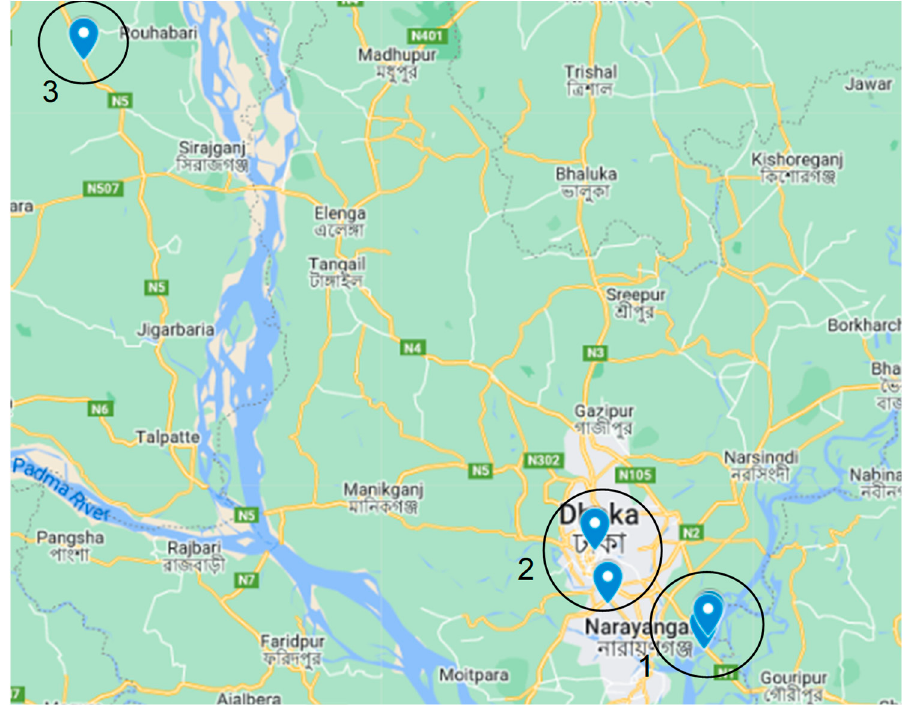
Figure 11. Area-based categorization of the studied plants [52].